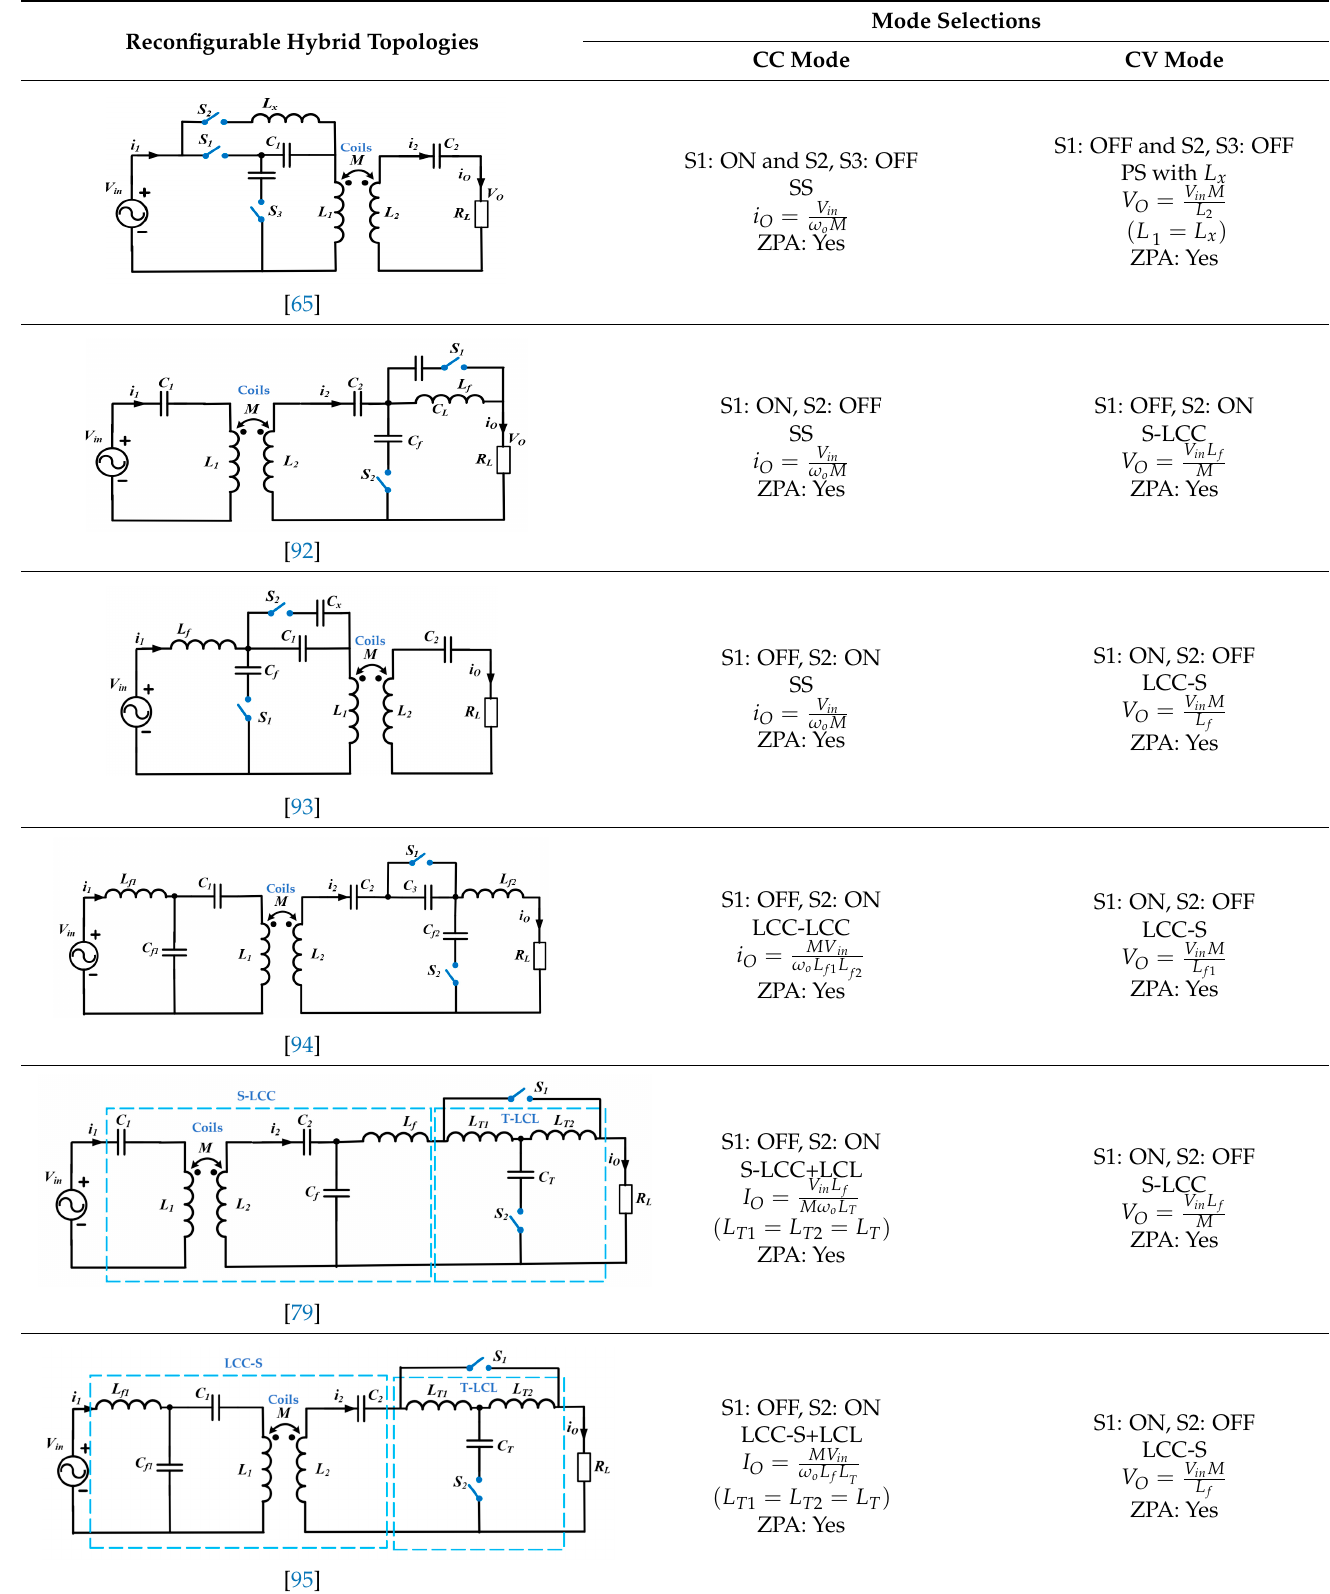
Table 4. Reconfigurable hybrid topologies with constant current and constant voltage configurations.